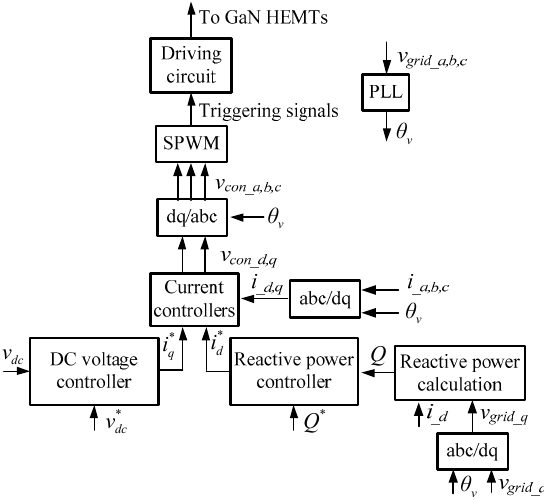
Figure 3. The proposed control architecture for GaN HEMTs-based three-phase STATCOM.